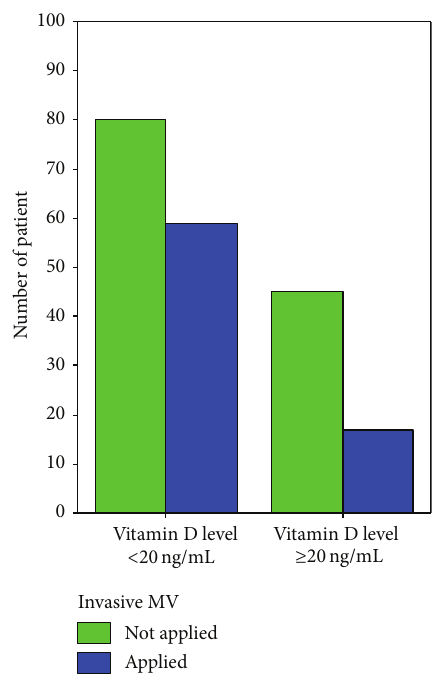
Figure10:ICUmortalityrateinvitaminDinsufficientandsufficient patients (𝑃 = 0.027)